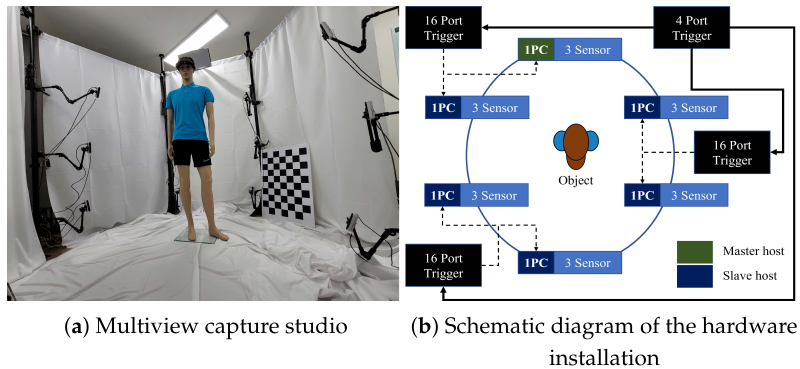
Figure 6. Multiview capturing system for 18 RealSense RGB-D cameras.